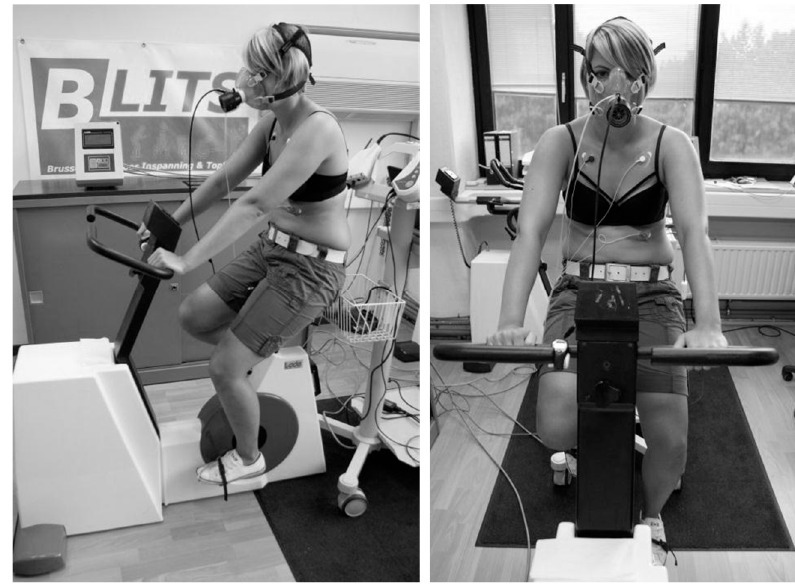
Figure 1. Set-up of the standardized submaximal bicycle exercise test.